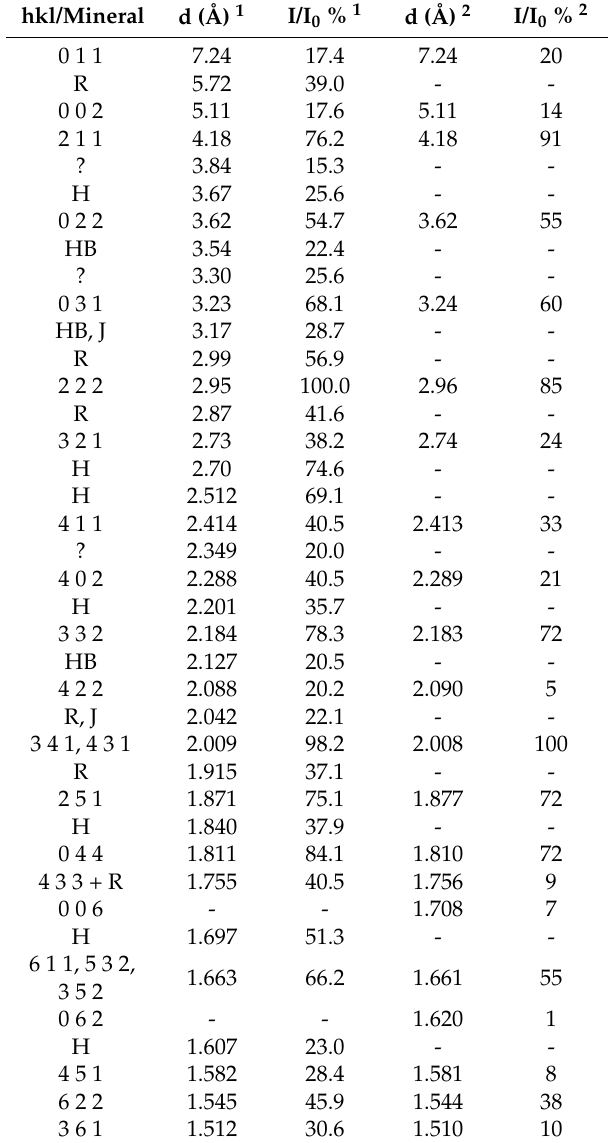
Table 1. X-ray powder diffraction data of verneite from Hekla (recorded with automatic variable divergence slit) compared with the experimental diagram of synthetic Na 2 Ca 3 Al 2 F 14 (PDF 36-1496). HB = mineral HB [1]; R = ralstonite; J = jakobssonite; H =